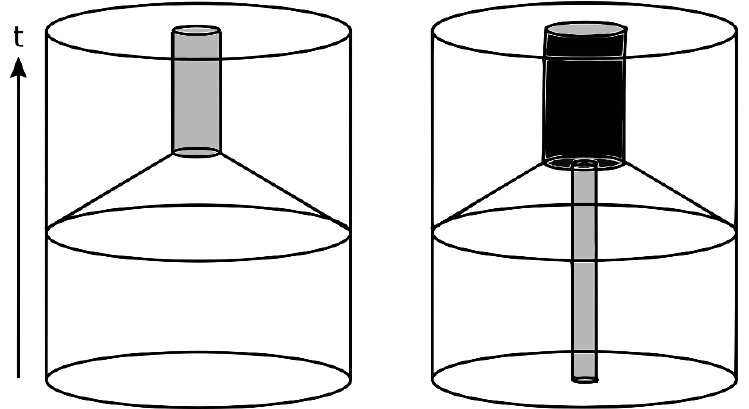
Figure 1 . The bulk gravitational picture is particularly intuitive. If a non-equilibrium collapse state is prepared that will collapse into a non-thermal geometry (e.g. a conical defect geometry), then if the experiment were to be repeated with an initial conical defect with mass m in the asymptotic past, then there exists a critical value of m such that the conical defect is pushed over the critical opening angle and a BTZ black hole is formed